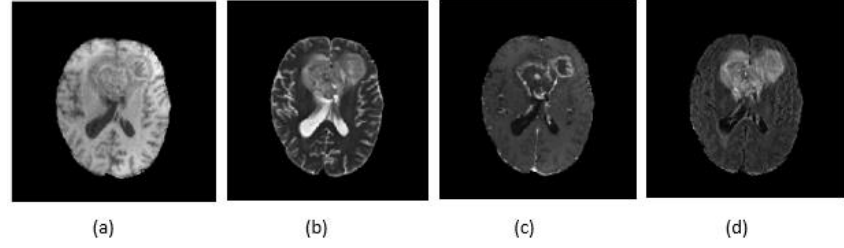
Figure 3. Different modalities of MRI images: ( a ) T1; ( b ) T2; ( c ) T1c; and ( d ) FLAIR.